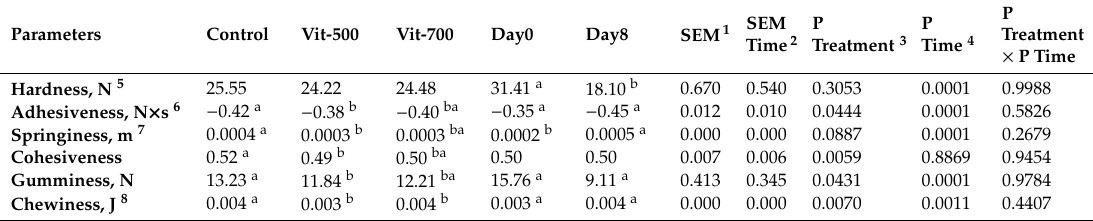
Table 6. Texture parameters in muscle from pigs supplemented with vitamin D 3 at di ff erent doses (500,000 UI / l vs. 700,000 UI / l) or without supplementation prior to slaughter (experiment